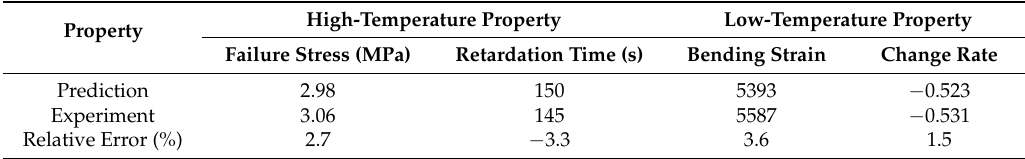
Table 10. Optimal value of multi-response for asphalt mortar.